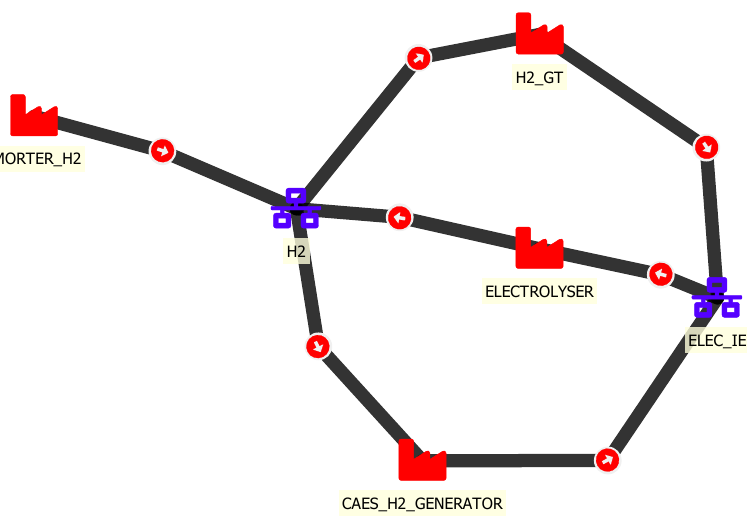
Figure 1. Simplified SpineOpt implementation of the Hydrogen